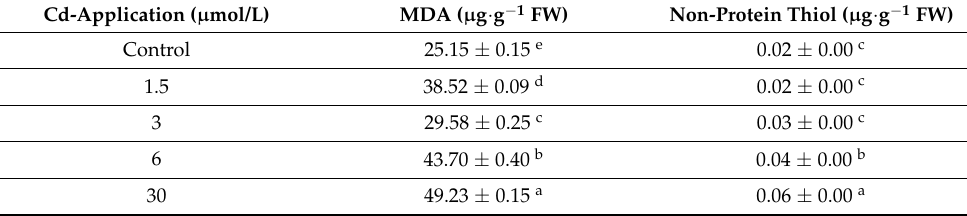
Table 2. The concentration of MDA and non-protein thiol in E. sativa in response to Cd